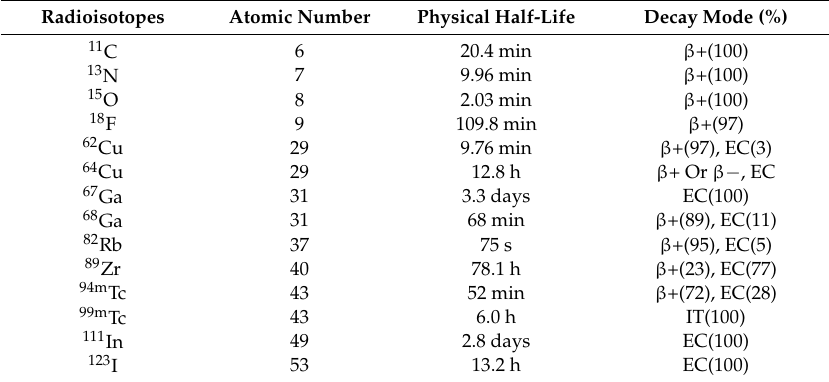
Table 1. Characteristics of common nuclear medicine radionuclides